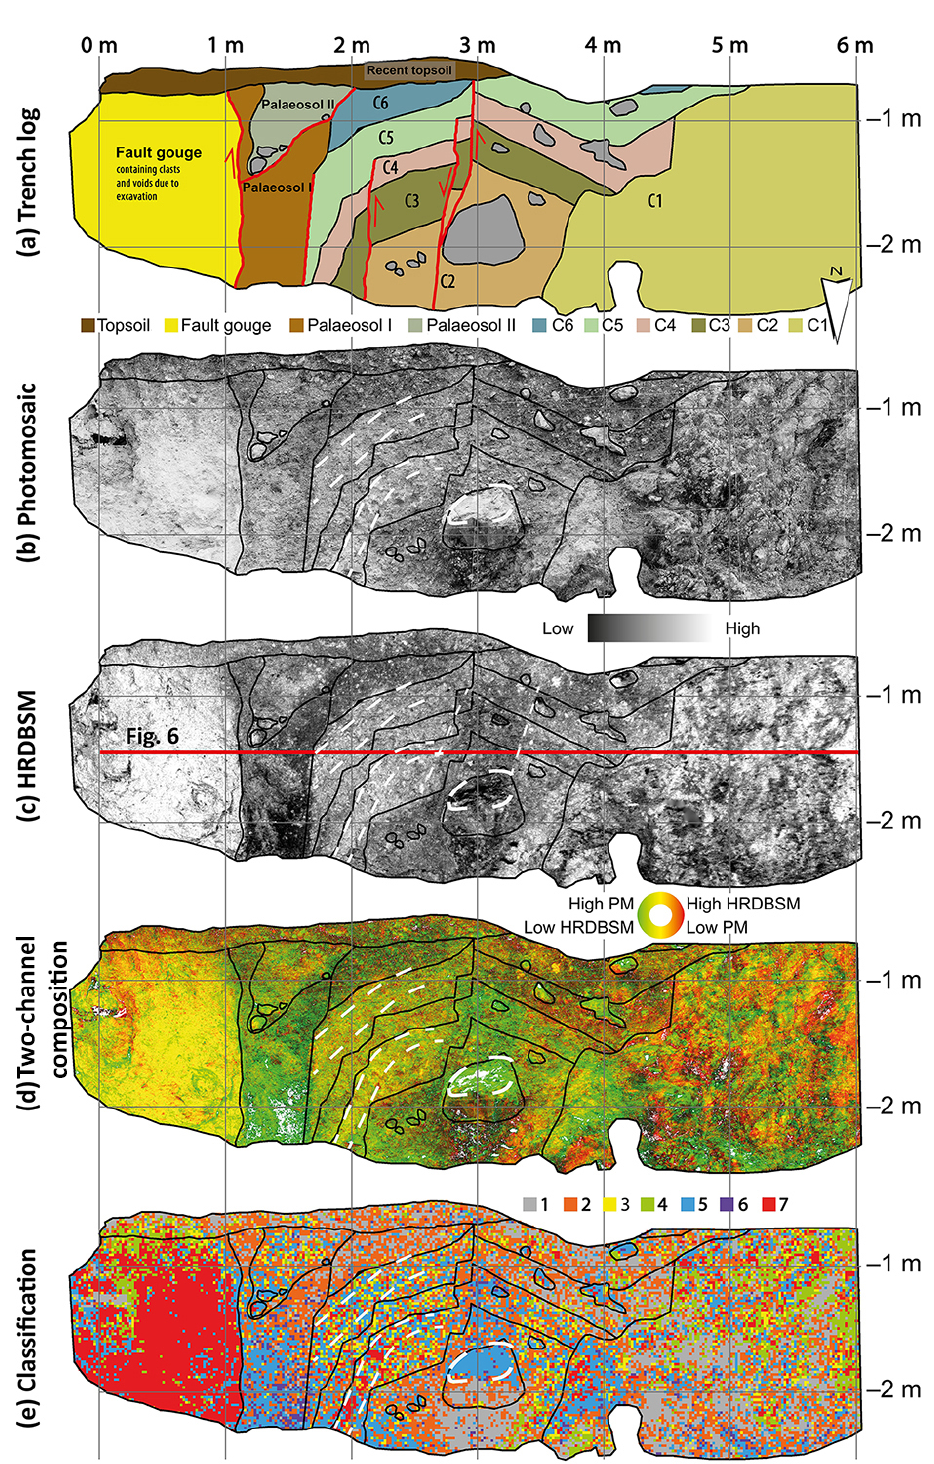
Figure 5. Compilation of analytical input and outcome at the Sfaka Fault road cut. (a) Trench log produced in the field and corrected with (b) photomosaic in the office. (c) High-resolution digital backscatter model (HRDBSM) from t-LiDAR measurements. (d) Two-channel composition from (b) and (c) . Note, green and red are 100% different (PM denotes photomosaic). (e) Visualisation of spatial distribution of seven classes from the unsupervised classification. White dashed lines indicate coinciding arrangements and some influence from daylight.